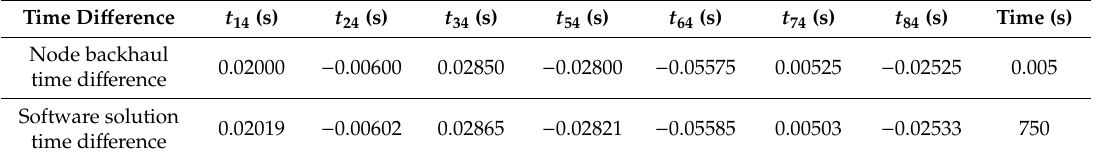
Table 4. Time-di ff erence values determined in the Table 4. Time-difference values determined in the test.